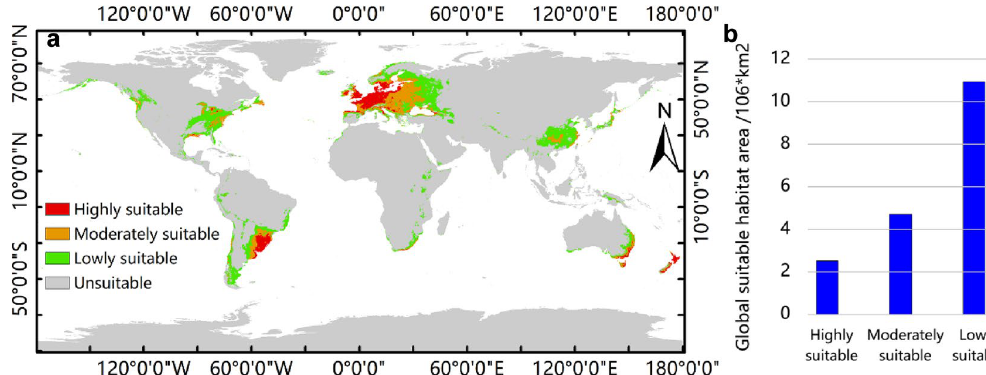
Figure 5. The predicted global suitable habitats of N. alata under current climate conditions. ( a ) global suitable habitats of N. alata , ( b ) global suitable habitat areas of N. alata. This base map was directly obtained from the calculation of MaxEnt with the bioclimatic data from WorldClim. Global bioclimate data were acquired from the WorldClim open database (https:// world clim. org). The locations of species occurrence were collected from open databases: GBIF (http:// www. gbif. org), the Chinese Virtual Herbarium (CVH, https:// www. cvh. ac. cn/), the National Specimen Information Infrastructure (NSII, http:// nsii. org. cn/ 2017/ About Us. php), and